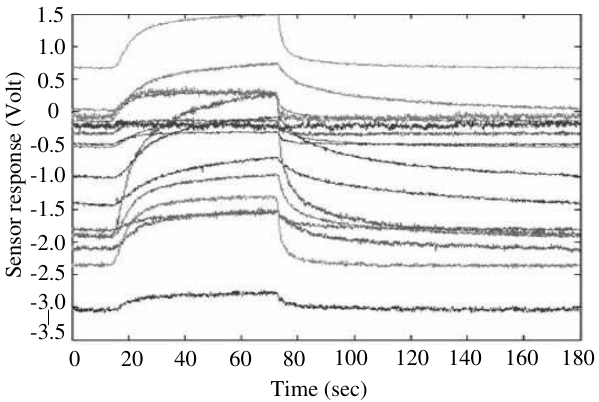
Figure 5. Typical time-responses of 16-channel sensor array with respect to the inflow of